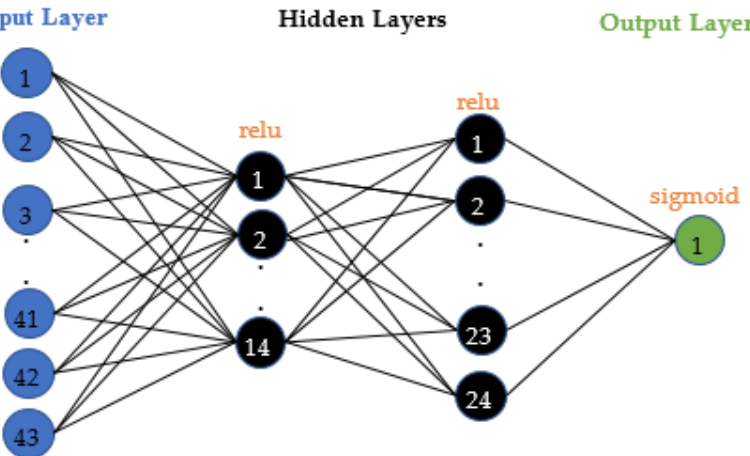
Figure 4. ANN model structure used in manual search case 1.